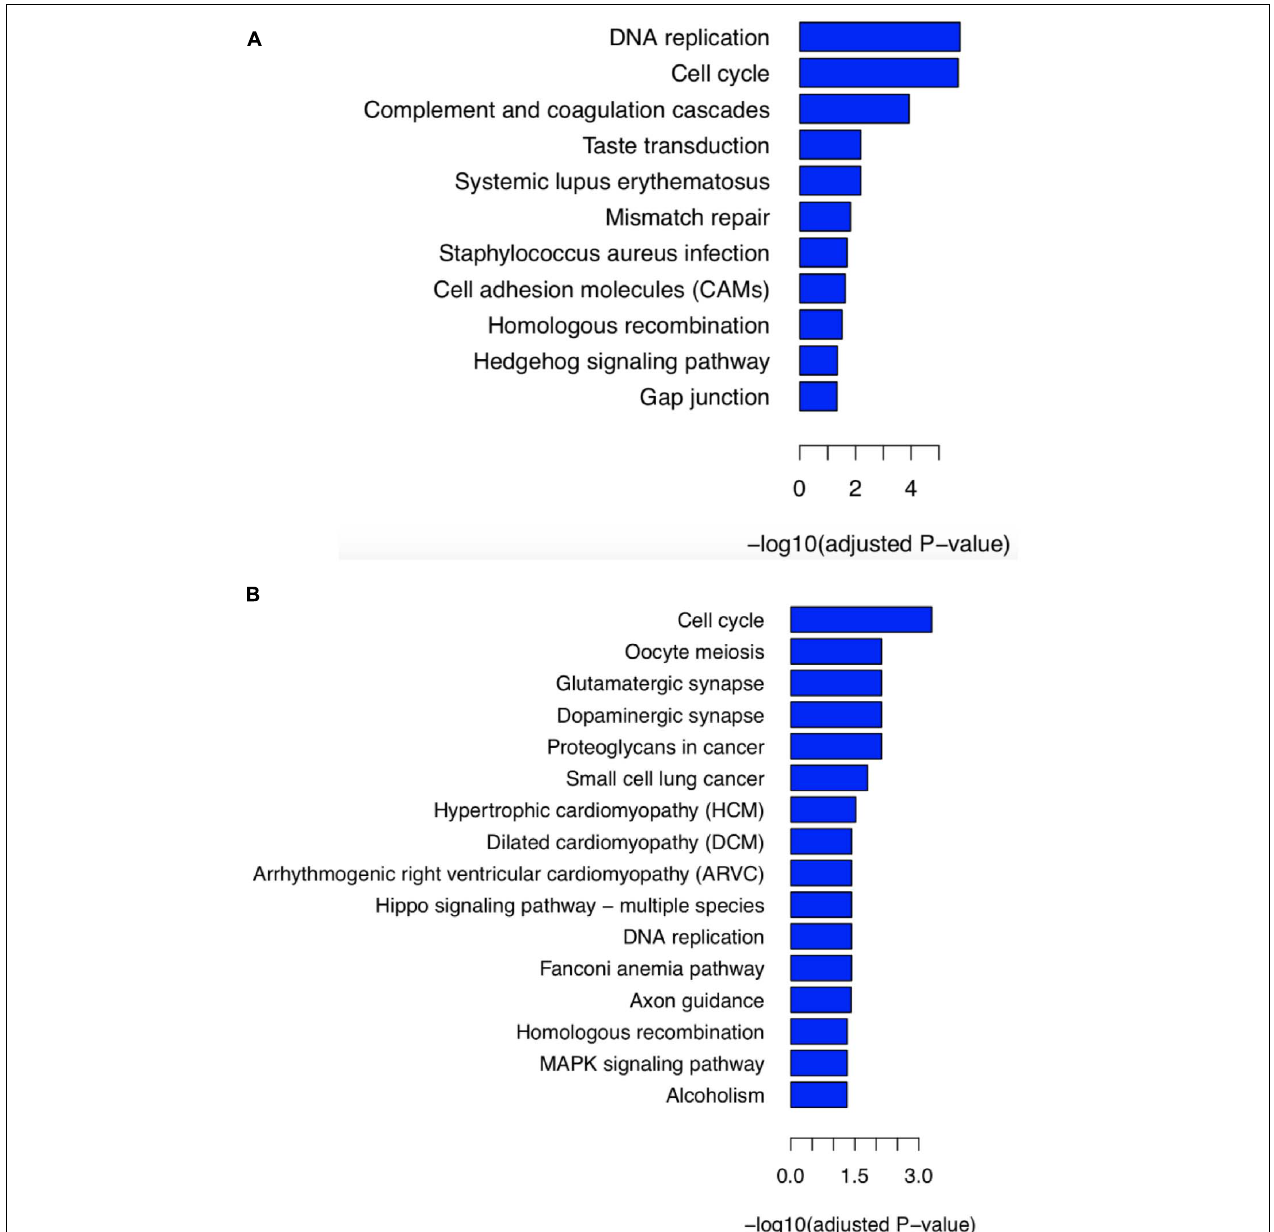
FIGURE 4 | KEGG pathway enrichment analysis of differentially expressed genes. (A) To analyze the contribution of stop-gain mutant BRCA2-S871Ter, analysis based on differential genes obtaining from RNA-seq data was performed between siblings and four samples with BRCA2-N372H variant belonging to the GSE62564 database. (B) To reveal whether the compound heterozygous mutant of BRCA2 contributed to the PNTs, we compared the siblings’ RNA-seq data, and 494 cases without either BRCA2-N372H or S871Ter mutant from the GSE62564